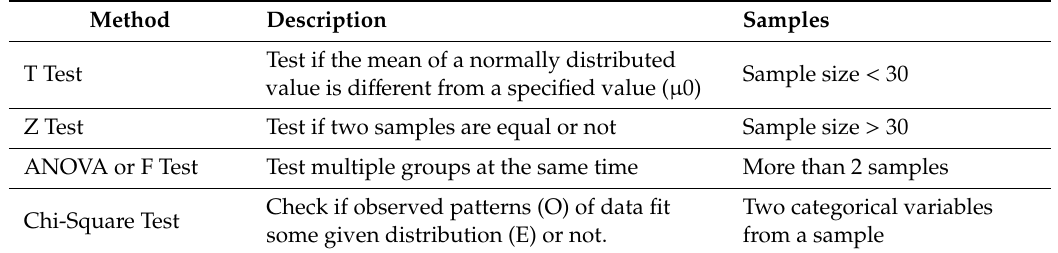
Table 7. Hypothesis testing